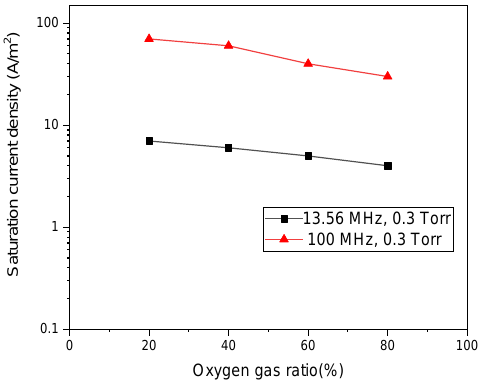
Figure 16. Dependence of electron current density with oxygen gas ratio at two different frequencies f = 13.56 MHz and f = 100 MHz with working pressure 0.3 Torr.